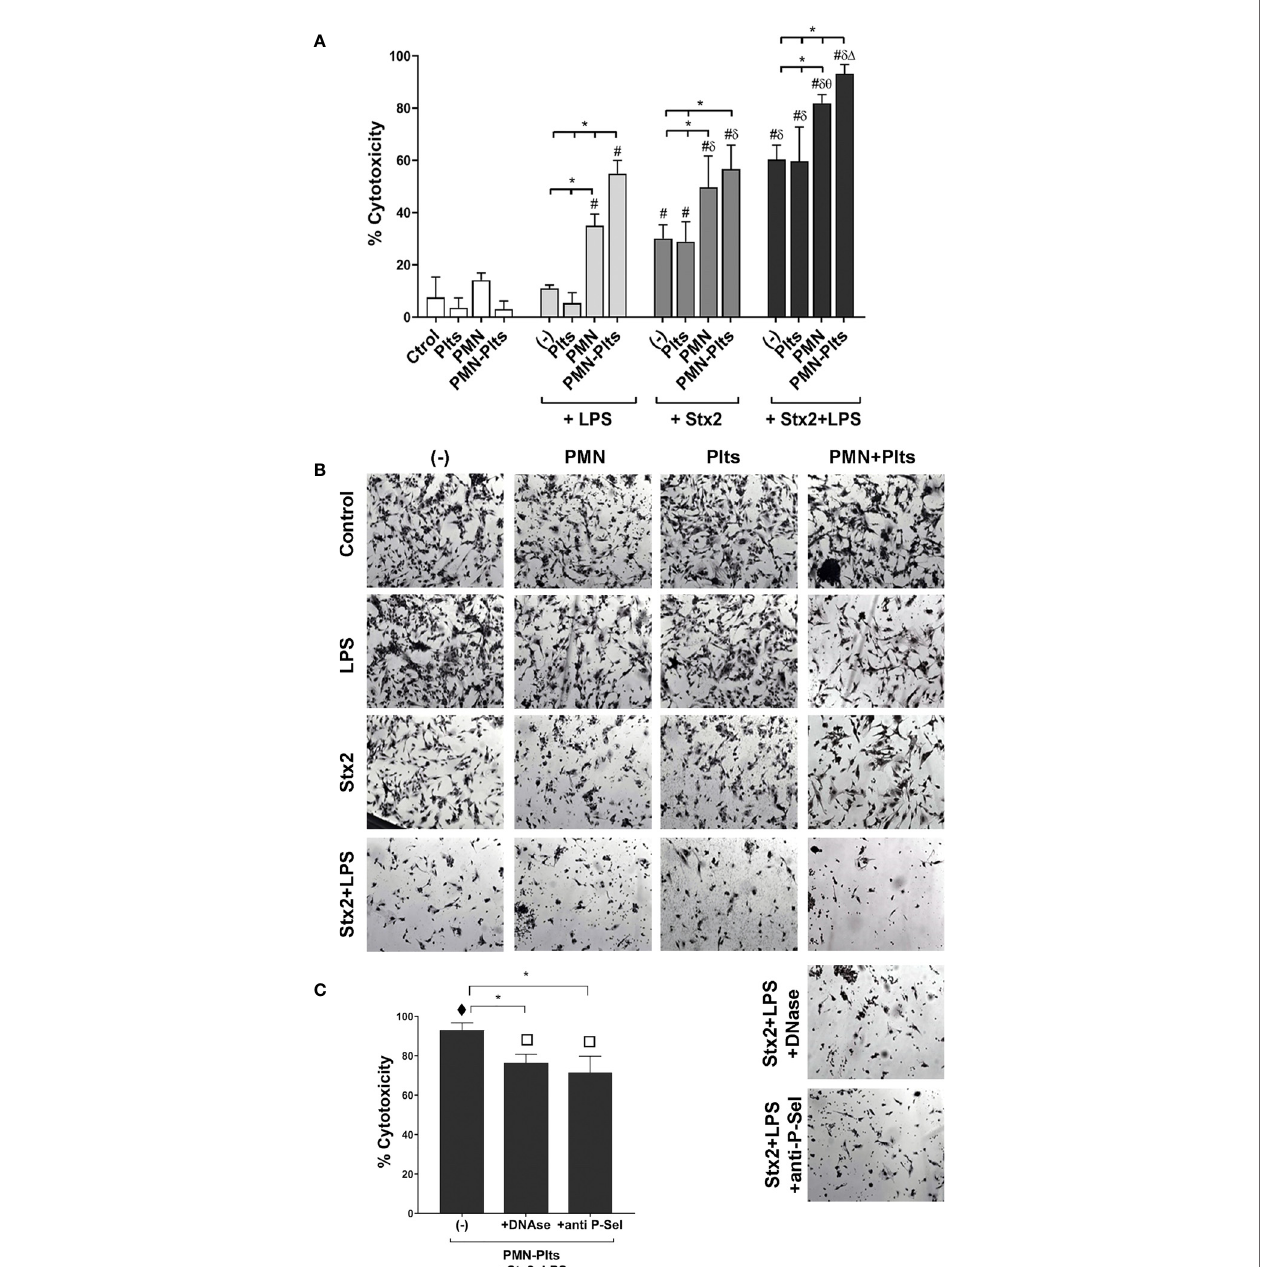
FIGURE 5 | Relevance of netosis and mixed aggregates formation on endothelial cell damage. (A) HMEC-1 were cultured with 20 ng ml − 1 Stx2 and/or 0.3 µg ml − 1 LPS alone, untreated, or treated PMN (HMEC-1/PMN ratio, 1:20), or untreated or treated Plts (HMEC-1/Plts ratio, 1:1,000) for 18 (h) The percentage (%) of cytotoxicity was determined by light microscopy after carefully washing of detached cells and was calculated as described in Materials and Methods (mean ± SEM) (n = 5). (B) Micrographs of one representative independent experiment (200×). (C) Treated Plts were co-incubated with PMN (PMN/Plts ratio, 1:50) for 10 min in the absence or presence of DNase or anti-P-selectin blocking antibody. Cells were then seeded on HMEC-1 monolayers for 18 h, and the percentage of cytotoxicity was determined as in Panel (A) (mean ± SEM) (n = 5). *p < 0.05; # vs. Ctrol, Plts, PMN, PMN – Plts, LPS, LPS+Plts; d vs. Stx2, Stx2 +Plts; q vs. LPS+PMN, Stx2+PMN; D vs. LPS+PMN – Plts, Stx2+PMN – Plts. t vs. all other groups from Panel (A) ; p vs. all other groups from Panel (A) except for